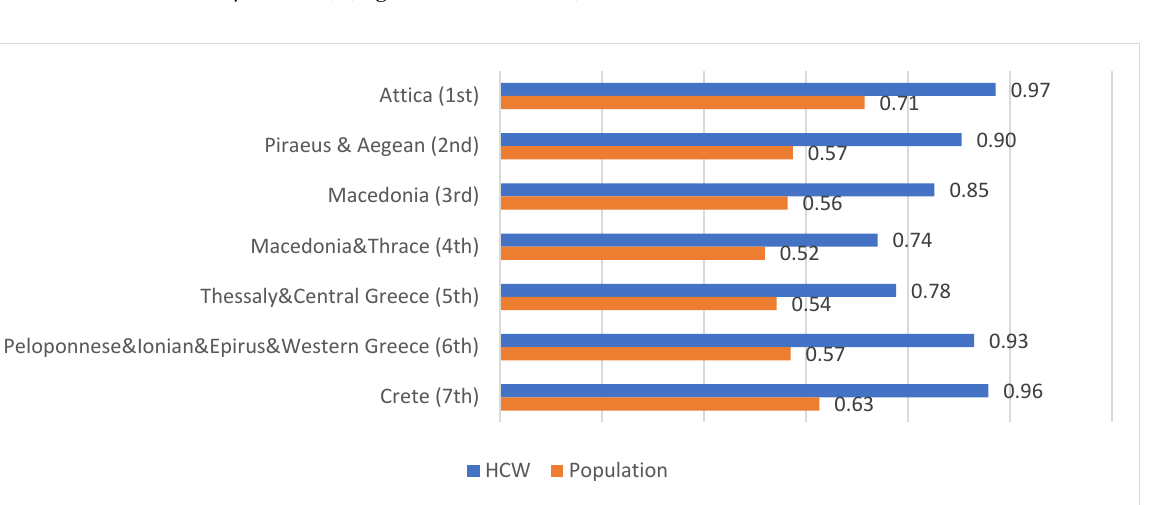
Figure 1. Distribution of reasons for COVID-19 vaccination refusal. According to data from the National Vaccination Registry, at the time of our survey, the countrywide proportion of COVID-19 vaccination in the general adult population was approximately 42% [24]. A strong positive correlation was identified between the percentage of vaccinated PHCC personnel and vaccinated adults in the general population (at least one dose) in each health district (Spearman’s correlation coefficient ρ = 0.991, p < 0.001) (Figure 2 and Table 5).